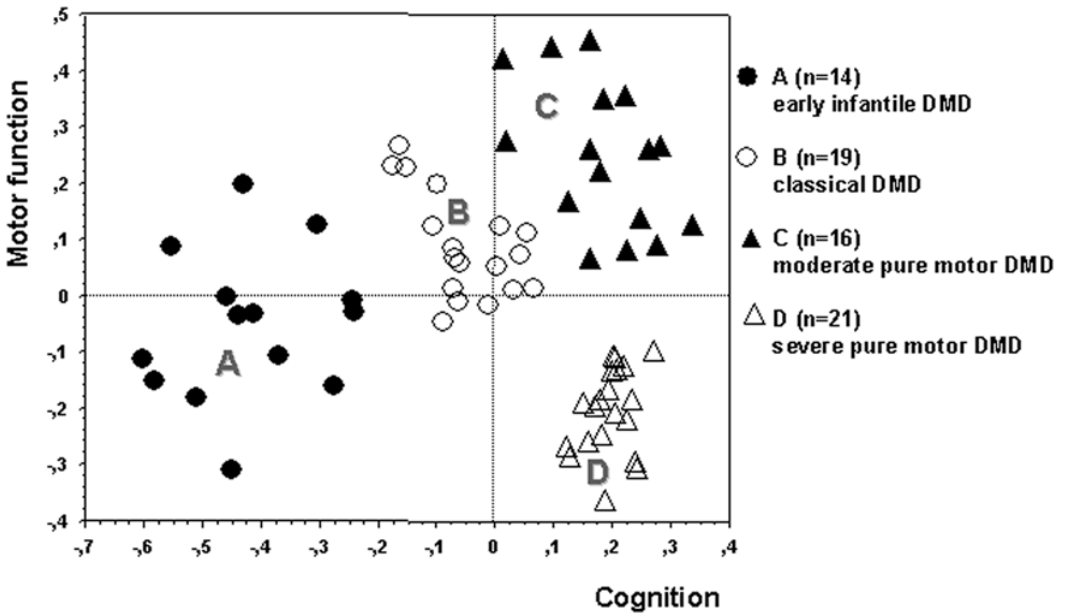
Figure 1. The 4-cluster solution. DMD patients were assigned to 4 clusters in the final hierarchical cluster analysis (linkage: Ward’s method, metric: squared Euclidean distance) using CatPCA-derived XY coordinates in a plane defined by the cognition and motor function principal components (axes) (Cronbach’s a : 0.859 and 0.721, respectively). Cognition was always altered to various extent in patients with early infantile DMD (A) and classical DMD (B), but was preserved in patients with moderate (C) and severe (D) pure motor DMD who differed markedly in motor function impairment. Overall, cluster A patients were most severely affected.